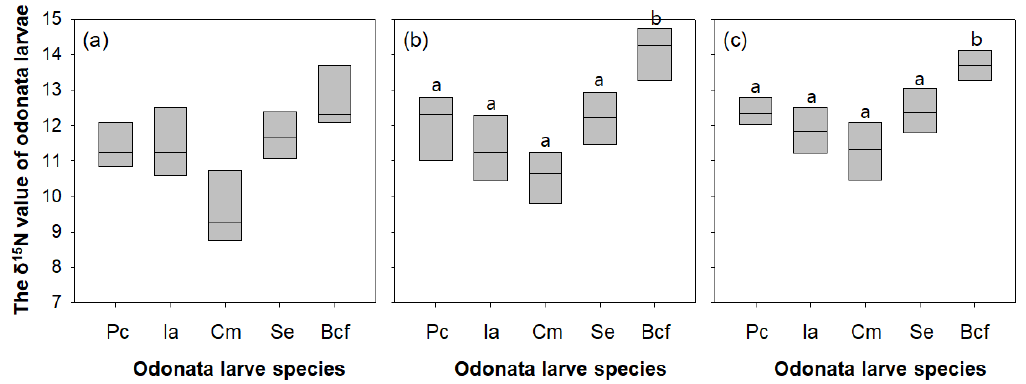
Figure 7. The δ 15 N value of each species of Odonata larvae in three wetlands (site 1, 5, and 14). Pc, Paracercion calamorum ; Ia, Ischnura asiatica ; Cm, Ceriagrion melanurum ; Se, Sympetrum eroticum ; Bef, Brachydiplax chalybea flavovittata . The three graphs (a, b, and c) represent different three study sites (from the left, site 1, 5, and 14). Means labeled with a different letter indicate statistical subgroups defined by the post hoc test (Tukey honestly significant difference (HSD), p = 0.05).